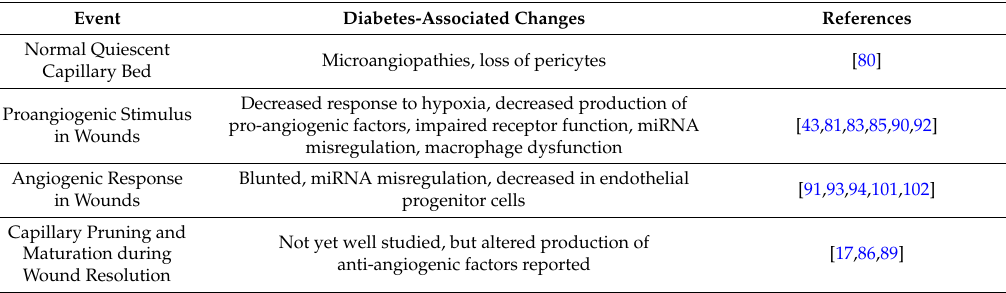
Table 1. Diabetes-associated changes in wound